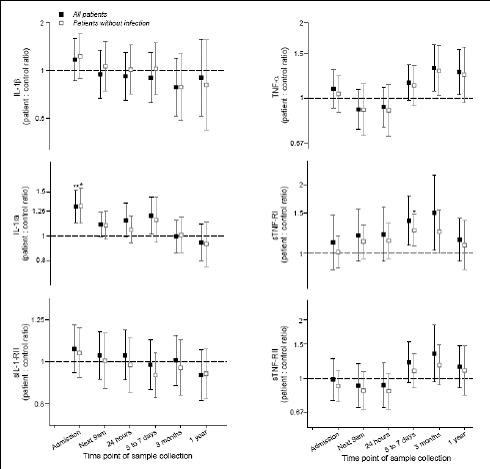
Plasma cytokine kinetics in all patients and patients without infection (in the 6 weeks preceding assessment). Patient values are expressed as multiples (ratios) of their corresponding controls (with 95% CIs) to account for skewed distributions. The 24 h time point includes "next 9 am" data where admission was between 07:00 and 11:00. *p ≤ 0.01 **p ≤ 0.001 (relative to controls).